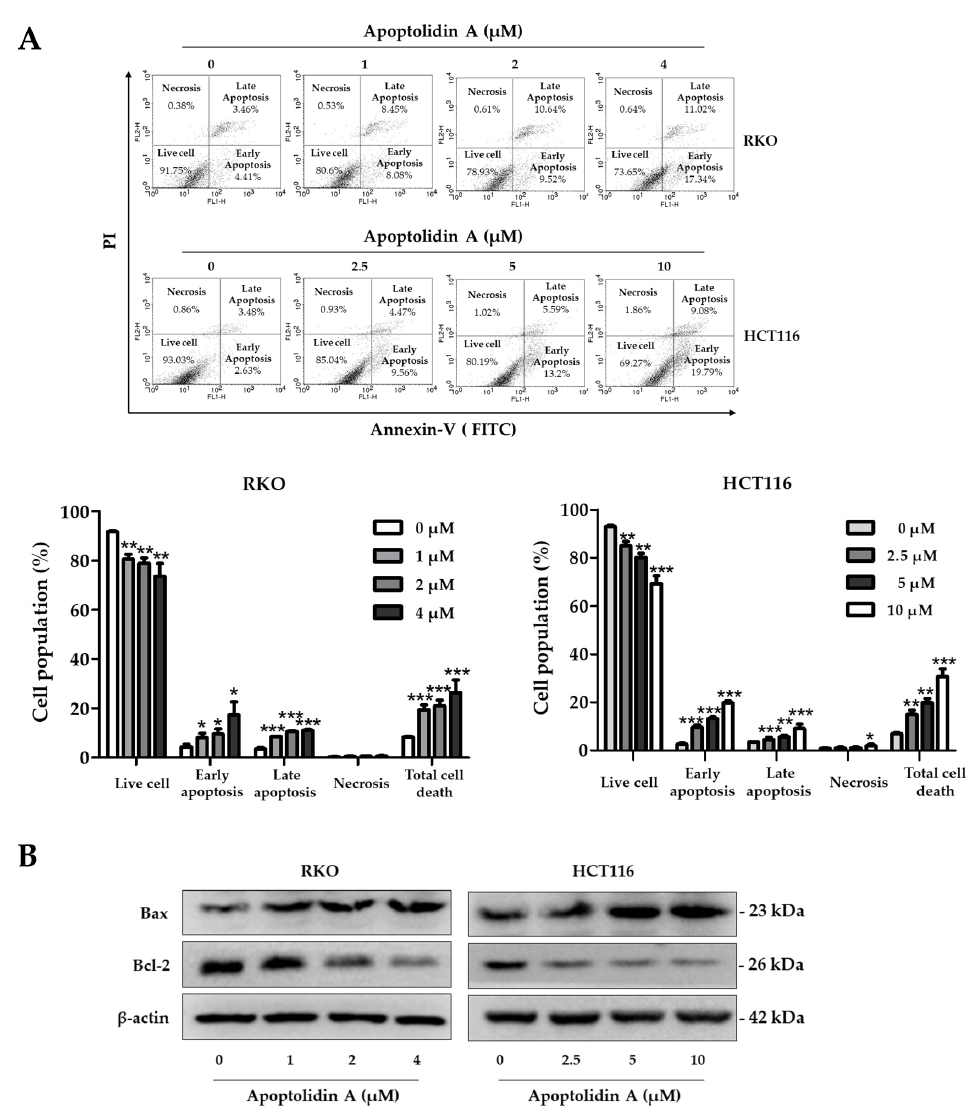
Figure 3. Effects of apoptolidin A on the induction of apoptosis in CRC cells. ( A ) RKO and HCT116 cells were treated with the indicated concentrations of apoptolidin A for 48 h before being stained with annexin V-fluorescein isothiocyanate (V-FITC) and PI for flow cytometry. Data are presented as the mean values ± SD from three-independent experiments. * p < 0.05, ** p < 0.01, and *** p < 0.001 indicate statistically significant difference compared to the vehicle-treated control. ( B ) Immunoblot analysis was used to assess the protein expression of Bax and Bcl-2 following a 48 h treatment of apoptolidin A. β -Actin was used as an internal